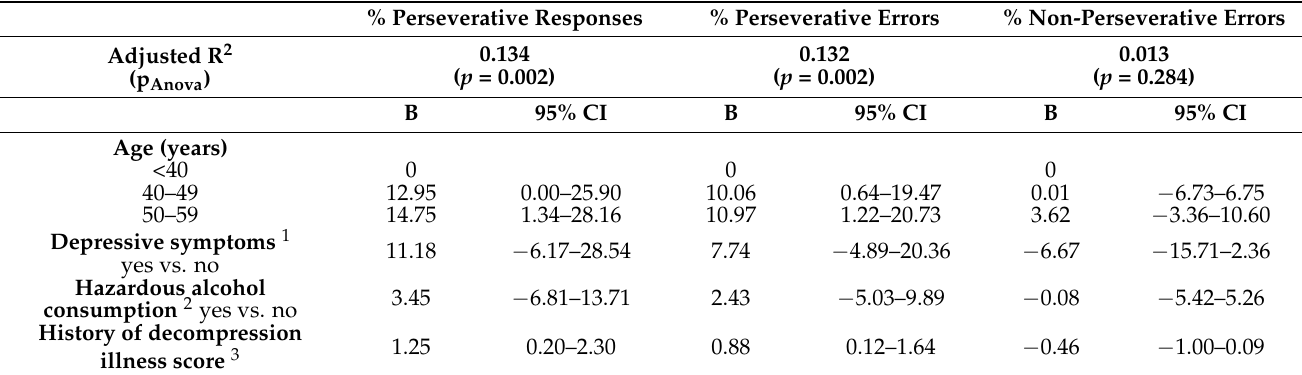
Table 3. Linear regression models to assess the severity and frequency of decompression illness as a risk factor for reduced executive functioning among divers. The models were adjusted for age, depressive symptoms, and hazardous alcohol consumption; N = 103 divers with complete